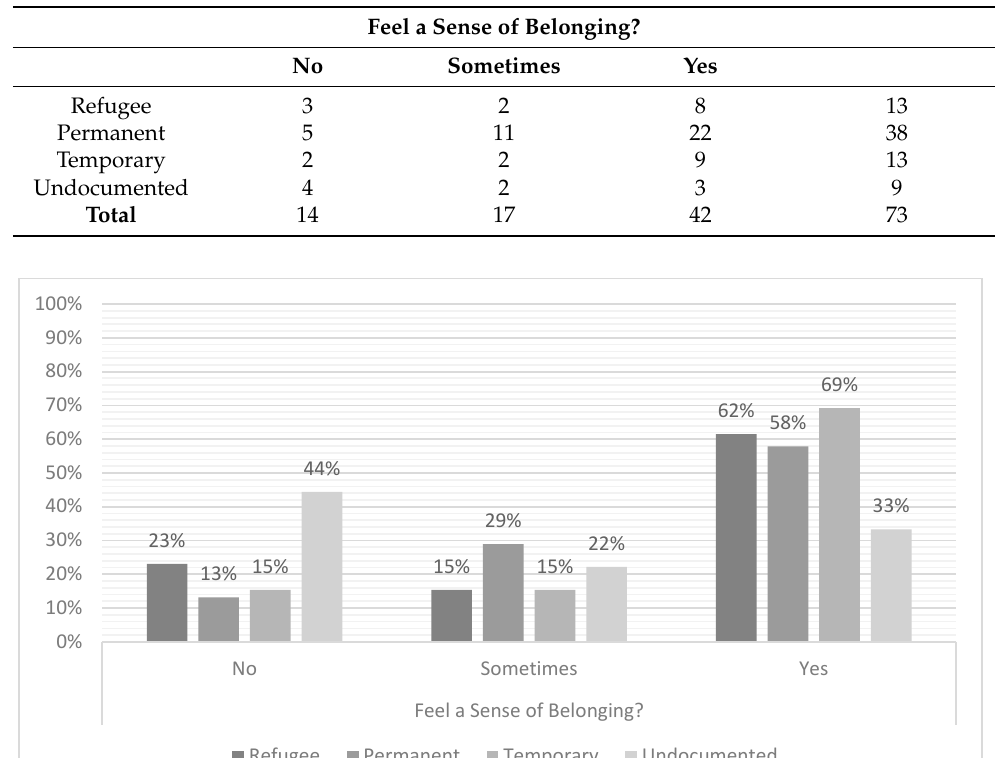
Table 2. Sense of Belonging by Legal Status.